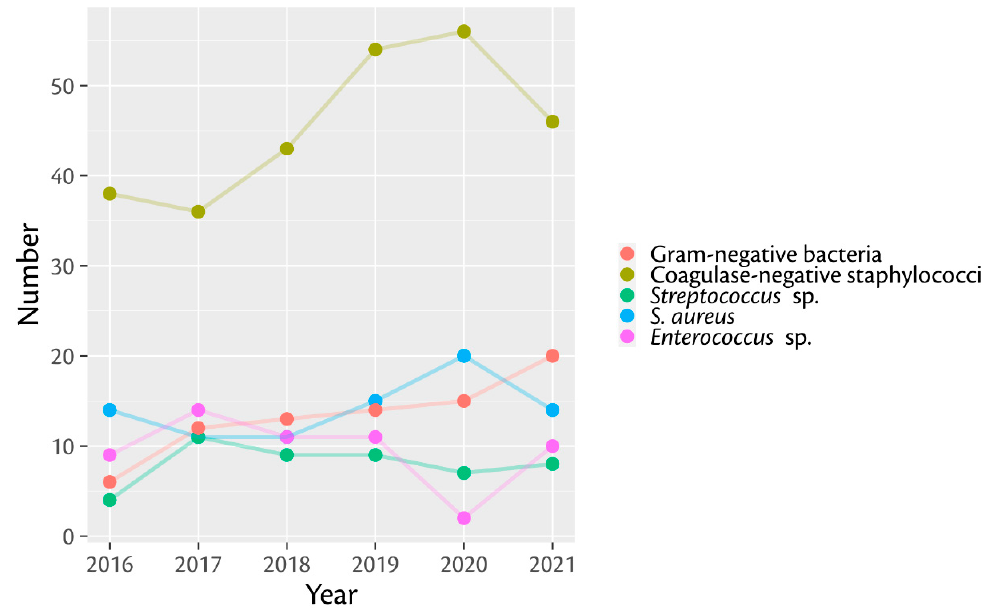
Figure 1. Annual detection rates of the five most common pathogens from 2016 to 2021 (vertical axis: number of detected pathogens; horizontal axis: years; sp.: species). Statistical analysis for coagulase-negative staphylococci ( p = 0.52) , S. aureus ( p = 0.85) and Gram-negative bacteria ( p = 0.31) did not show a significant change in the detection